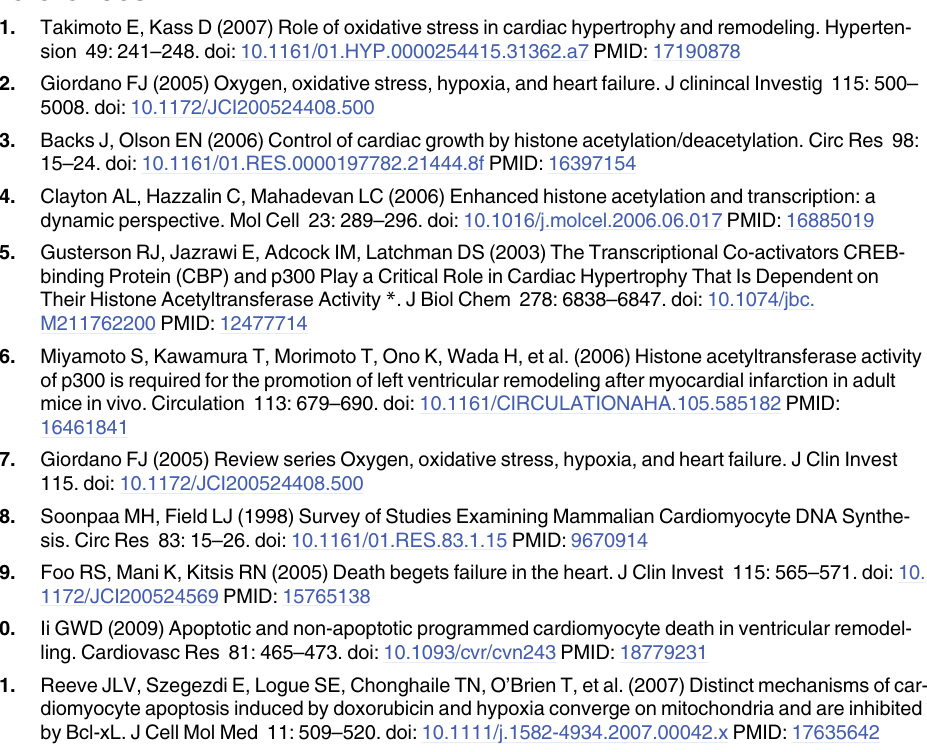
(TIF) S4 Fig. Changes in mean fluorescent intensity in MnSOD in HVCM cells: Values are mean ± SD, significant values represented as @@ p (cid:1) 0.01 vs normoxia, (cid:3) p (cid:1) 0.05 vs hypoxia and # p (cid:1) 0.01 vs hypoxia. No significant change was observed in nanocurcumin or curcumin treated cells under normoxia (ns). under various experimental groups exposed to hyp- S5 Fig. Figure showing changes in Δ C m oxia for 24h. Values are mean ± SD, significant values represented as @@ p (cid:1) 0.01 vs normoxia, (cid:3) p (cid:1) 0.05 vs hypoxia and # p (cid:1) 0.01 vs hypoxia. ns depicts non-significant changes.